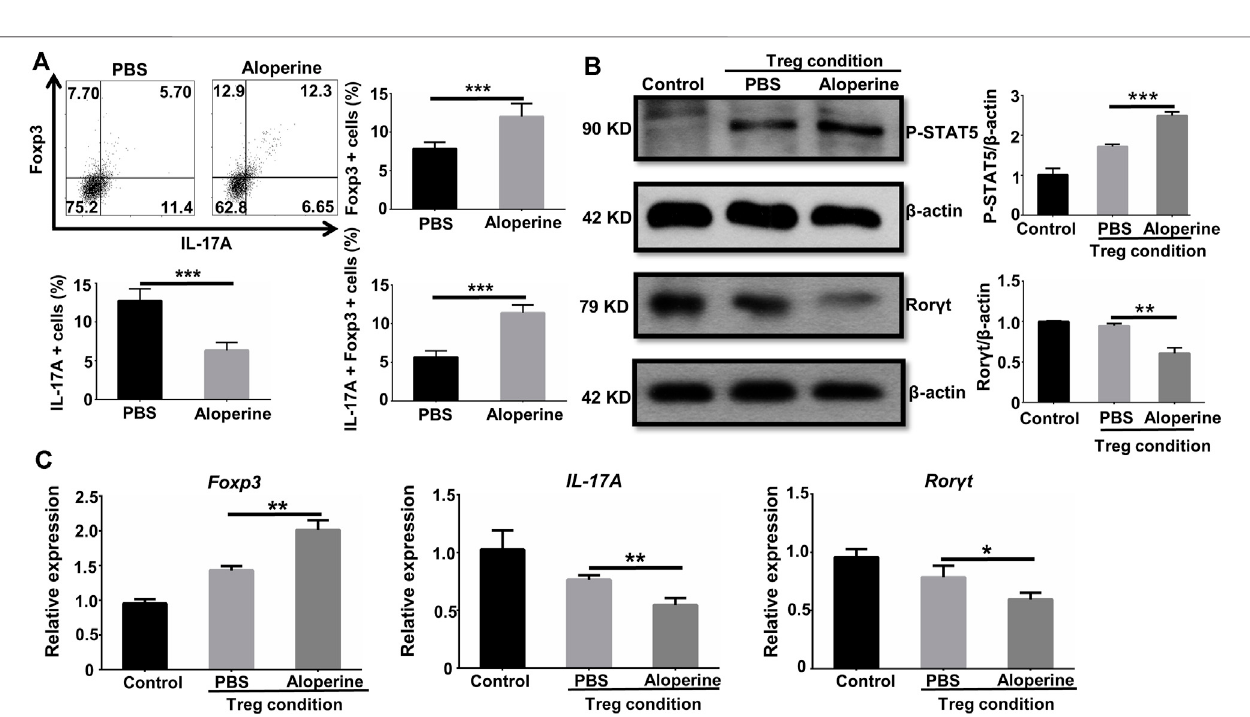
FIGURE 6 | Aloperine facilitates the conversion of Th17 to Treg. (A) Flow cytometry analysis of the conversion of Th17 into Treg. (B) Western-blot analysis was conducted to assess the in fl uence of aloperine in the phosphorylation of STAT5 and STAT3. (C) Real-time PCR analysis of IL-17A, ROR γ t, and Foxp3 in Th17 cells following 48 h of Treg polarization conditions with or without aloperine. The results were from three independent experiments. The values are presented as the mean ± SEM. p p < 0.05; pp p < 0.01; and ppp p < 0.001.